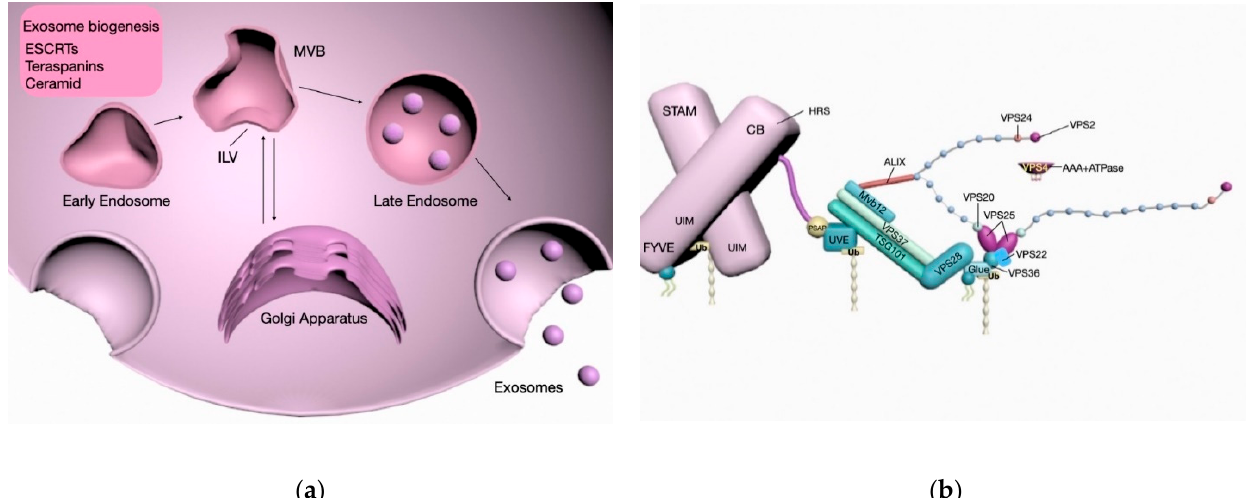
Figure 1. Schema of the molecular mechanisms and interactions involved in exosome biogenesis. Exosomes can be formed as intraluminal vesicles (ILVs) in an endosomal sorting complex required for transport (ESCRT)-dependent manner, as well as via ESCRT-independent pathways involving molecules such as ceramide, tetraspanins, and proteoglycans prior to their secretion ( a ). Post-translational modifications of the vacuolar protein sorting-associated proteins (VPS) family proteins involved in the sorting of exosomal cargo and generation. Energy required for the scission of budding exsomes from membrane is dependent on the ATPase activity of the Vacuolar protein 4 (VPS4) complex ( b ).